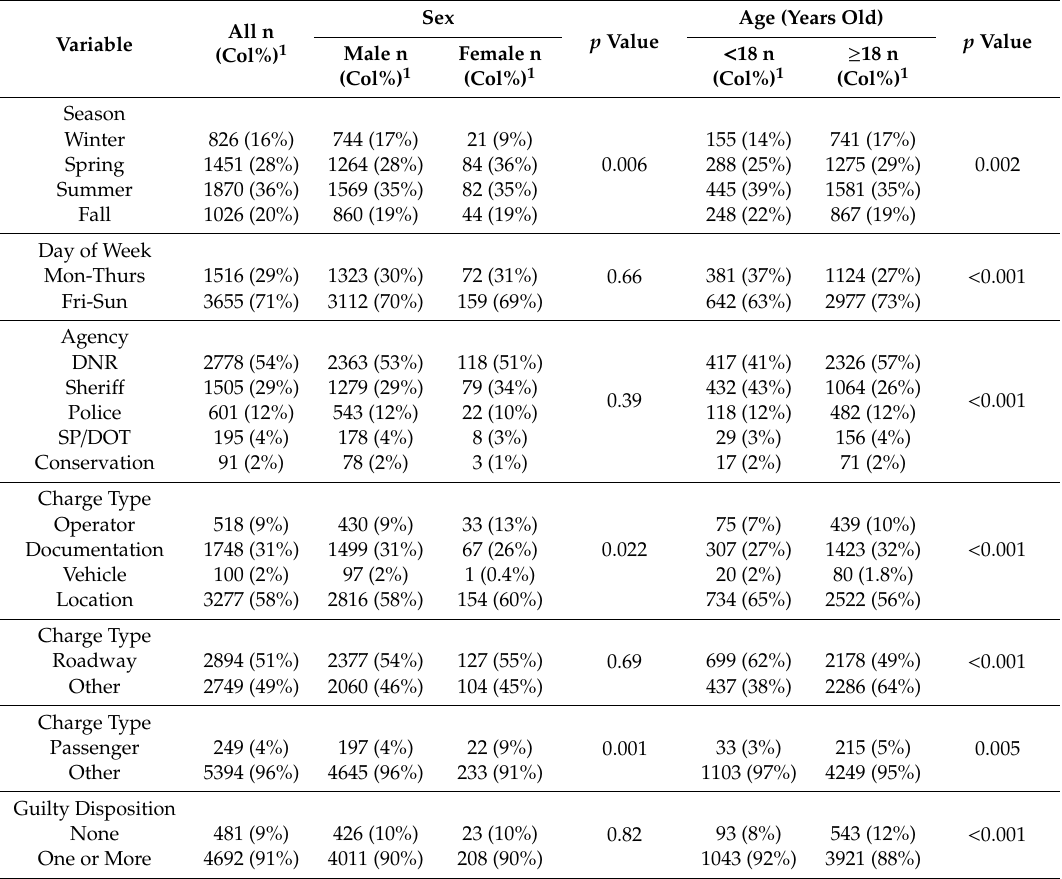
Table 3. Citation-related characteristics and demographic comparisons for o ff -road vehicle (ORV) citations in the Iowa Courts Information System (ICIS) from